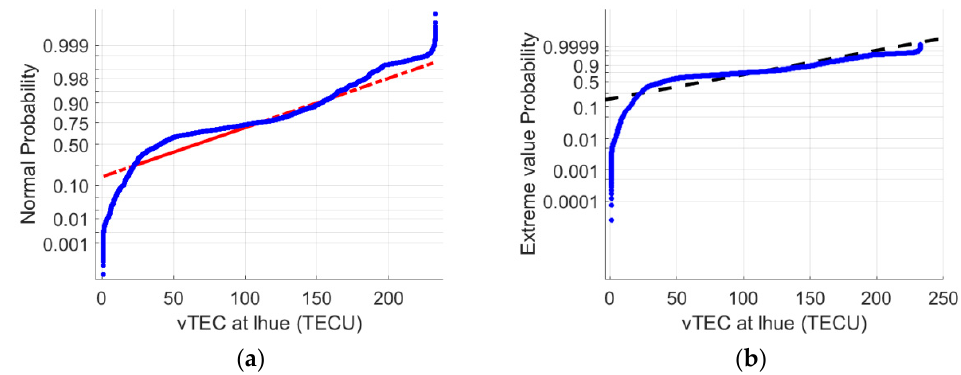
Figure 2. Probability distribution tests of TEC against the Normal (panel a ) and the Extreme Value (panel b ) distributions. The TEC data are from the SIO3 station from 30 October 2003. Red and black broken lines represent normal and extreme value distribution, respectively.